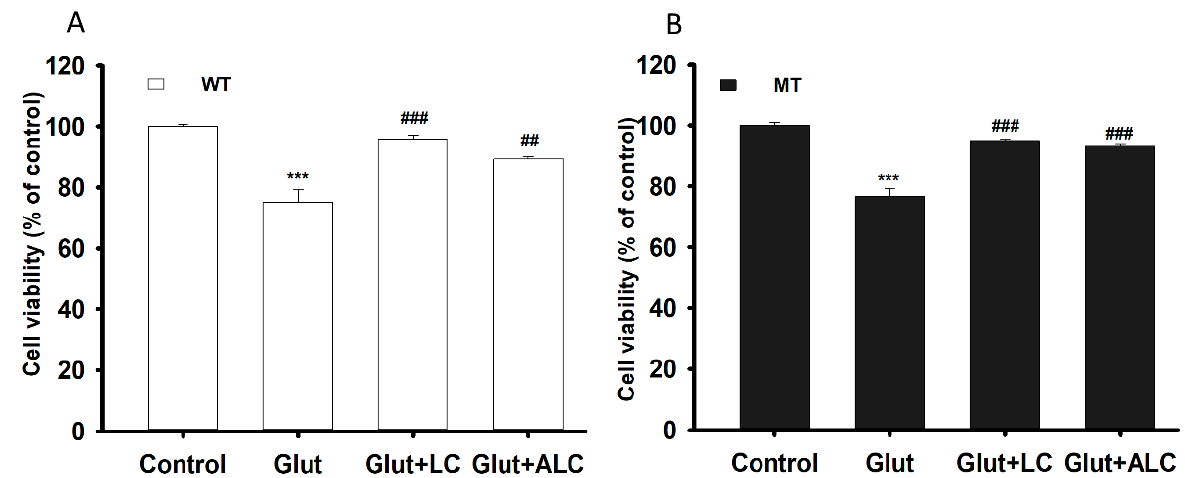
Figure 7. L-Carnitine (LC) and acetyl L-carnitine (ALC) ameliorates the neurotoxicity induced by the glutamate (Glut) in NSC-34 WT ( A ) and MT ( B ) cell lines. The cell viability was analyzed through the MTT assay after the pretreatment of glutamate with or without LC and ALC at a concentration of 1 mM for 24 h. Each value represents the mean ± S.E.M ( n = 4). *** p < 0.001, versus control; ### p < 0.001 vs. glutamate; ## p < 0.01, vs.